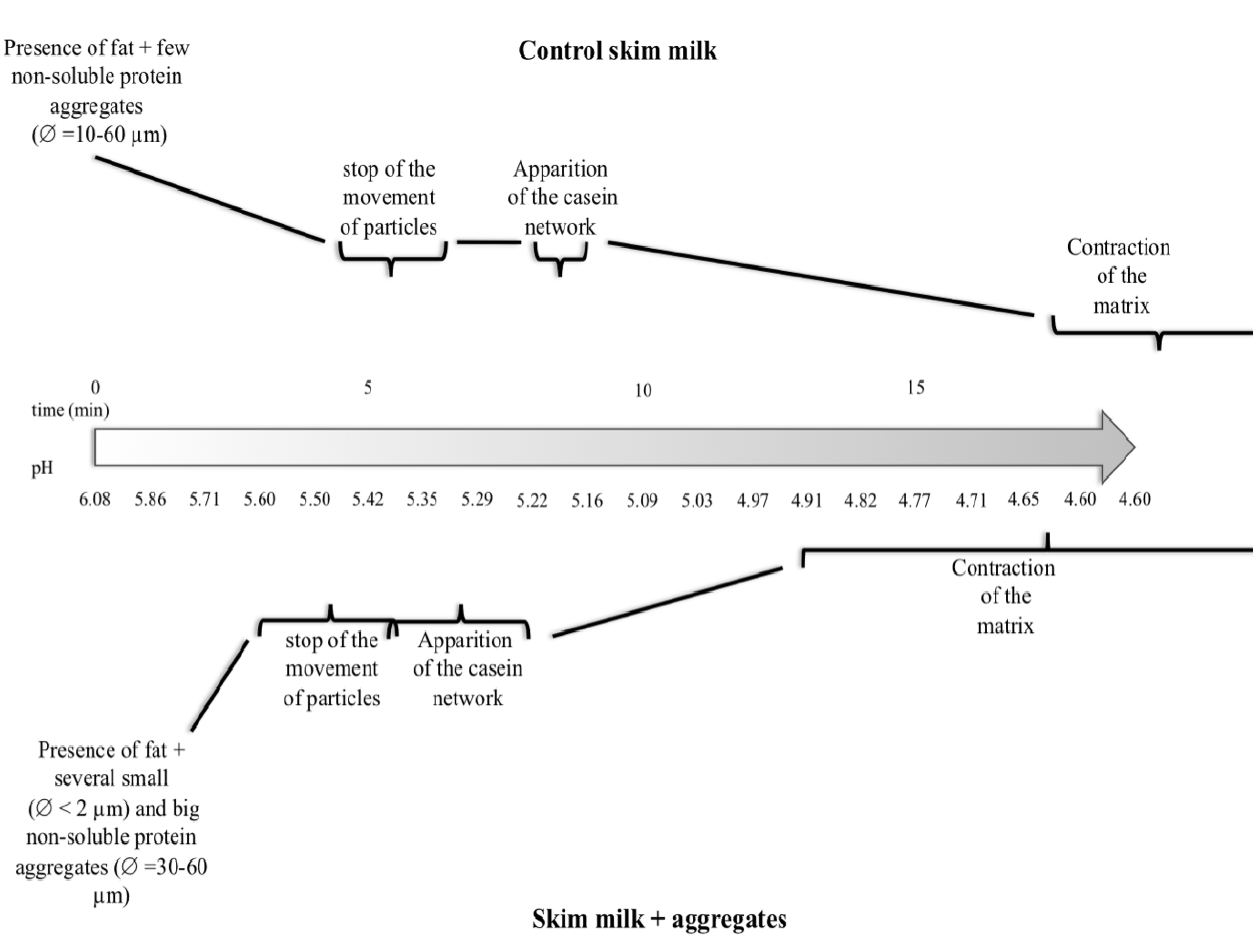
Figure 7. General trends observed in the videos of gel formation as a function of pH and